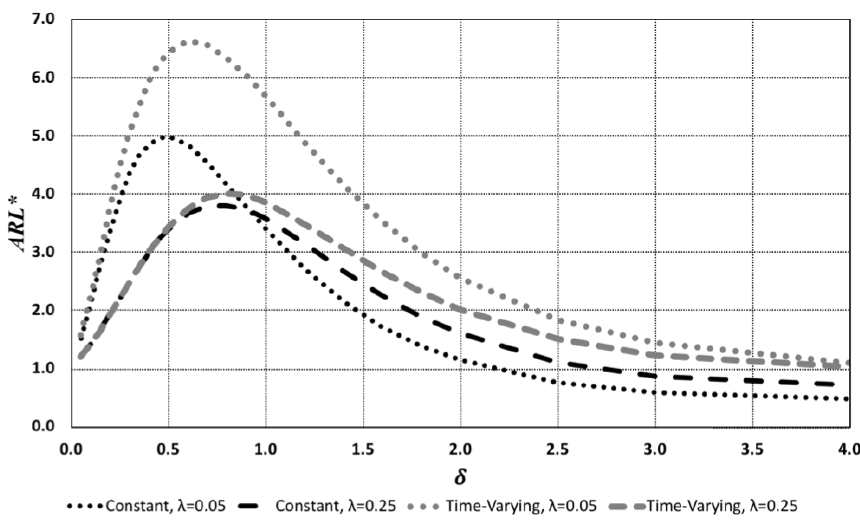
Fig. 3. Zero-state 𝐀𝐑𝐋 ∗ profiles for 𝐀 = −𝟎. 𝟓 .